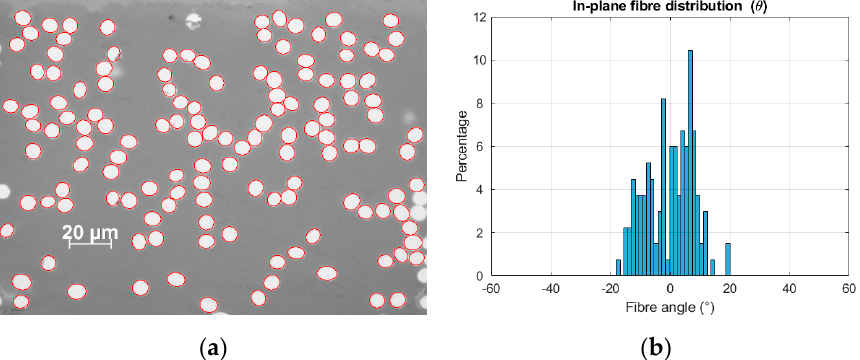
Figure 18. Fibre orientation analysis showing ( a ) ellipse fitting performed on PLA cross section and ( b ) resulting in-plane fibre distribution.